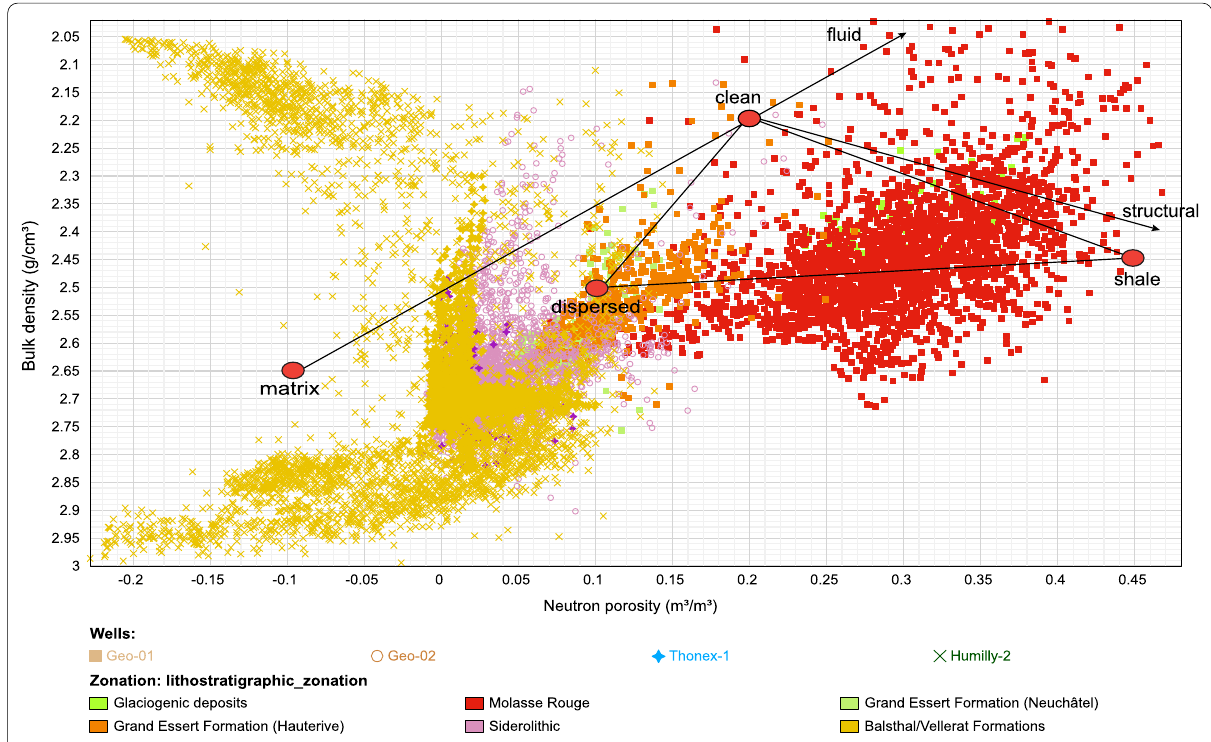
Fig. 15 Clay-type derivation using a Thomas-Stieber plot for 7 formations. A clear tendency towards dispersed shale is distinguished for the Hauterive Member of the Grand Essert Formation. Clay distribution for the Molasse Rouge ranges between the structural and dispersed